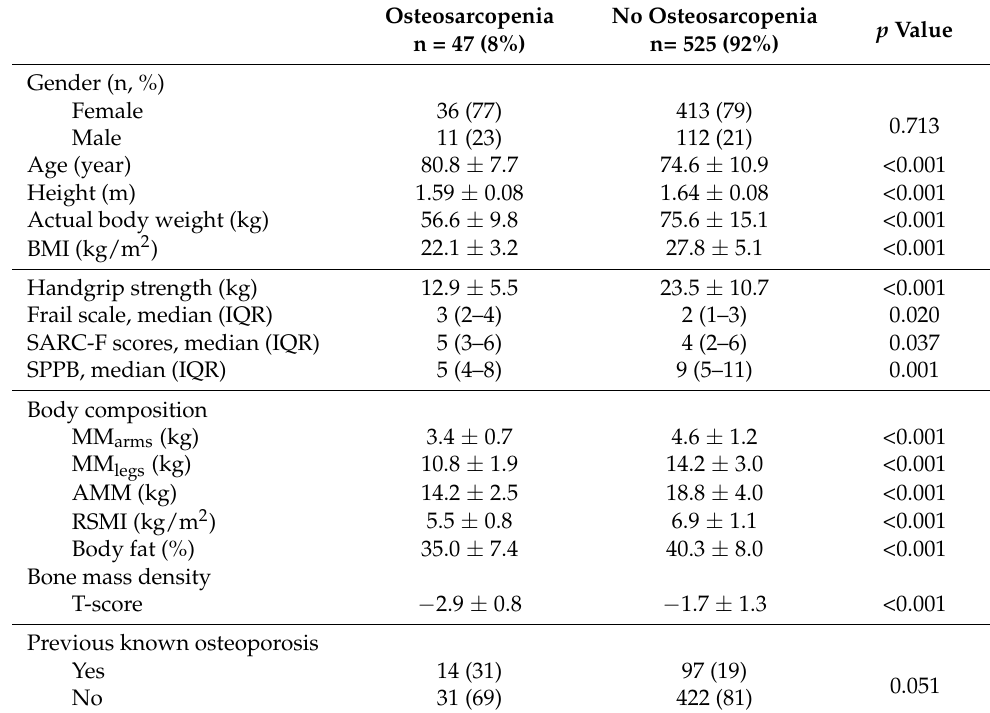
Table 5. Comparison of patients with and without